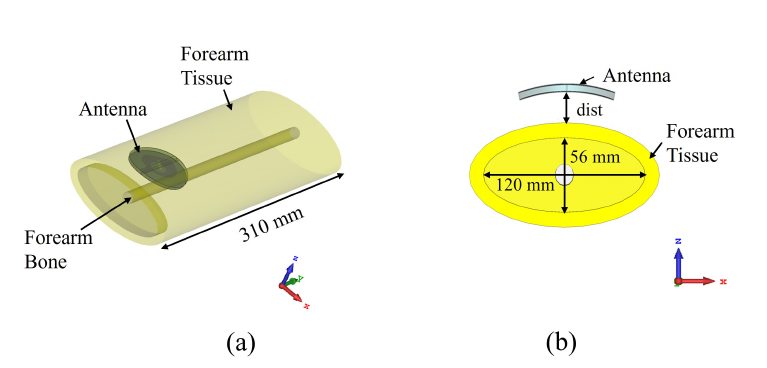
Figure 14. Antenna on top of the forearm phantom: ( a ) perspective view, ( b ) cross-sectional